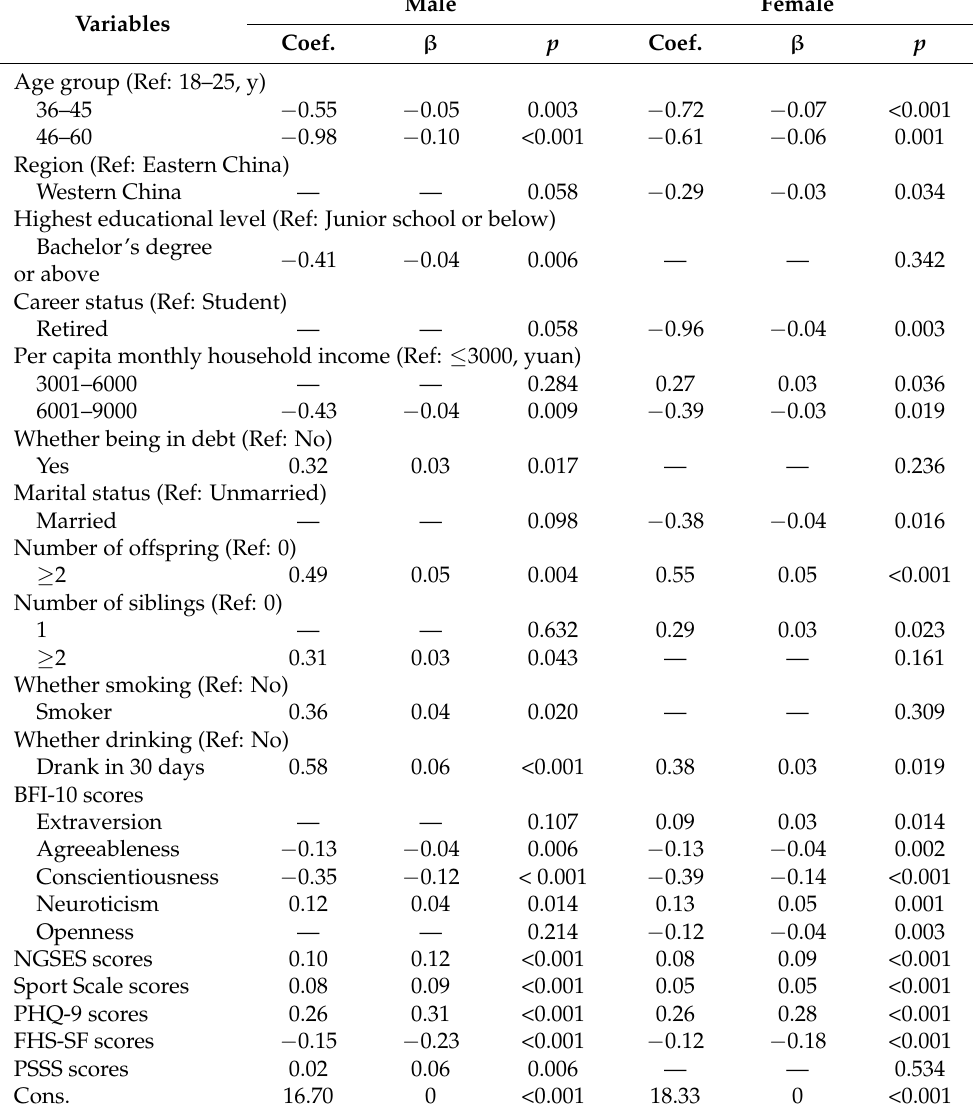
Table A5. The stepwise regression of associated factors for EBS-SF scores stratified by sex.